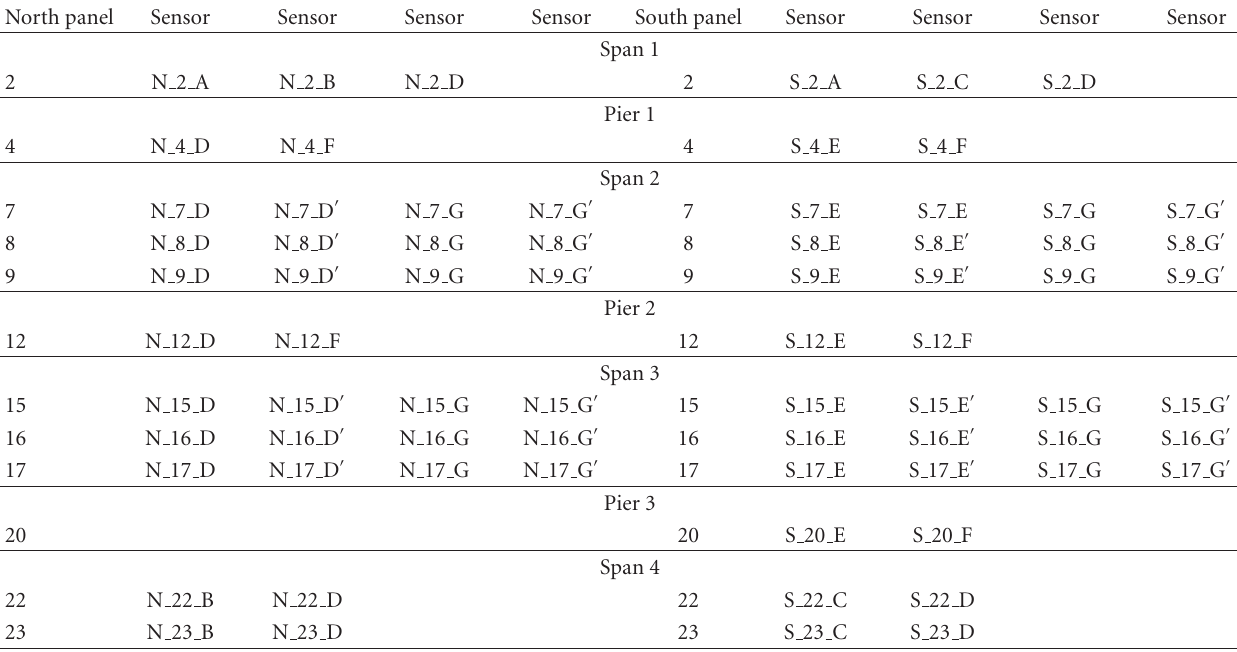
Table 3: Sensors used for transverse load stress monitoring (Group 2).